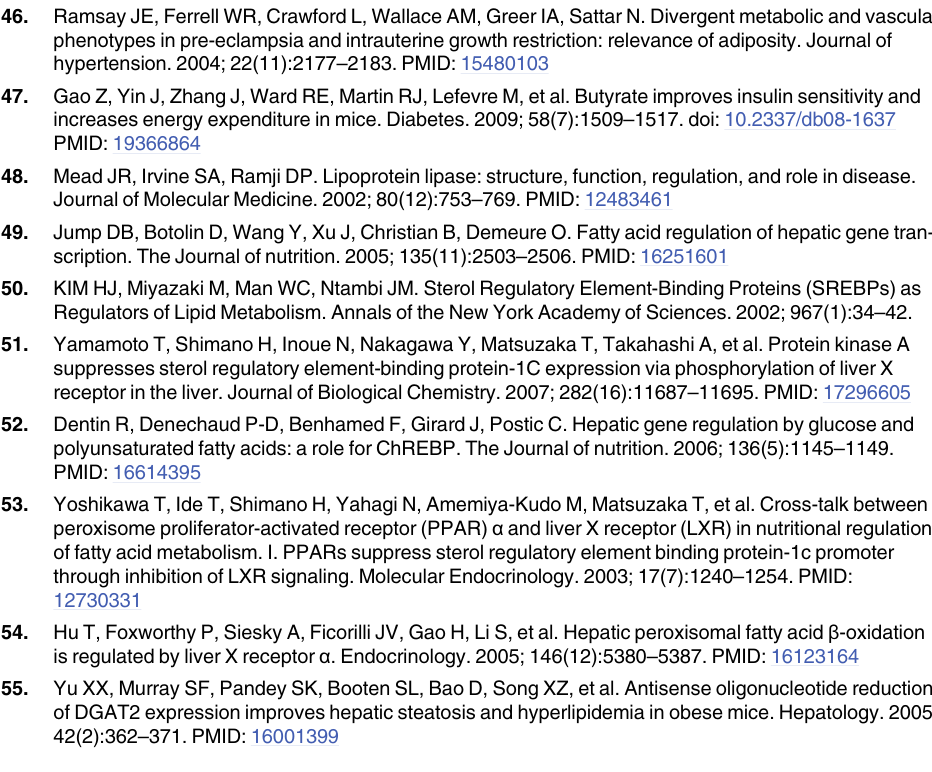
PLOS ONE | DOI:10.1371/journal.pone.0136848 August 28,